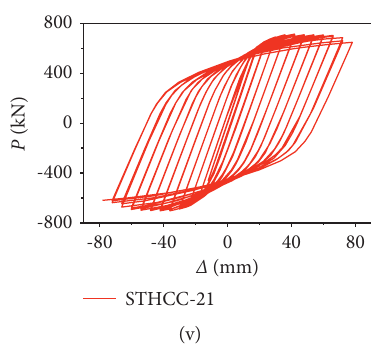
Figure 7: Hysteresis curves of 22 STHCCs. (a) STHCC1. (b) STHCC2. (c) STHCC3. (d) STHCC4. (e) STHCC5. (f) STHCC6. (g) STHCC7. (h) STHCC8. (i) STHCC9. (j) STHCC10. (k) STHCC11. (l) STHCC12. (m) STHCC13. (n) STHCC14. (o) STHCC15. (p) STHCC16. (q) STHCC17. (r) STHCC18. (s) STHCC19. (t) STHCC20. (u) STHCC21. (v)